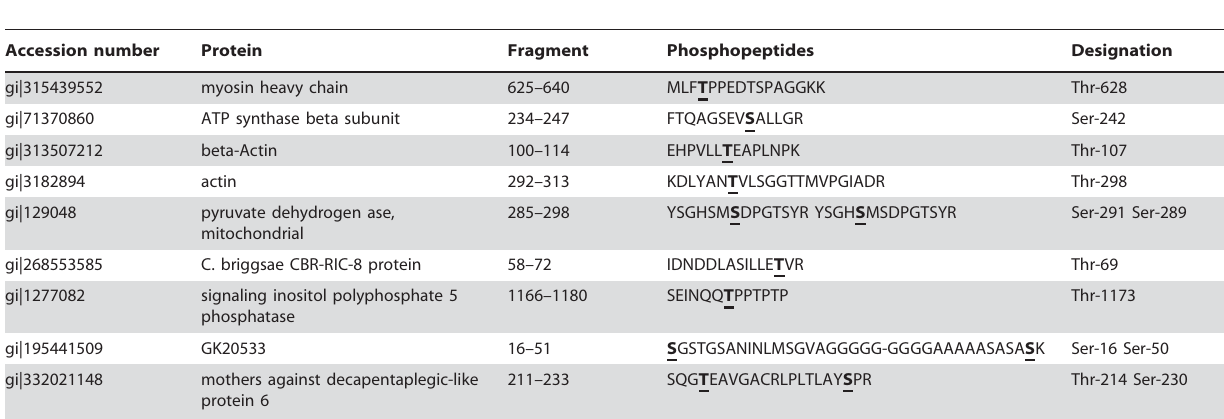
Table 2. Identified phosphorylated proteins and phosphorylation sites in 3–4 segmented larvae by IMAC enrichment followed LC- MS/MS.